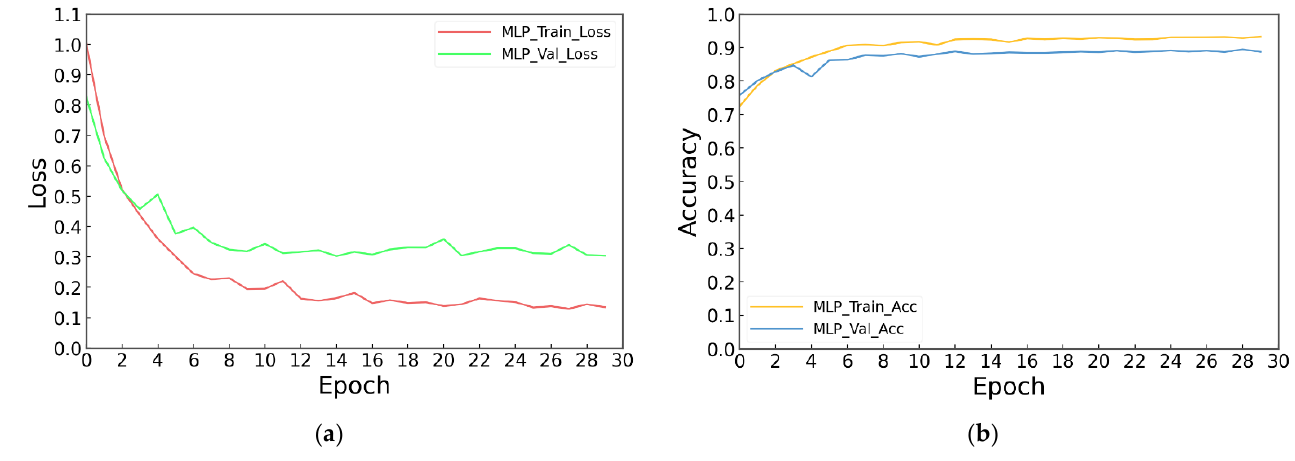
Figure 7. ( a ) The loss of the classification model. ( b ) The accuracy of classification model.